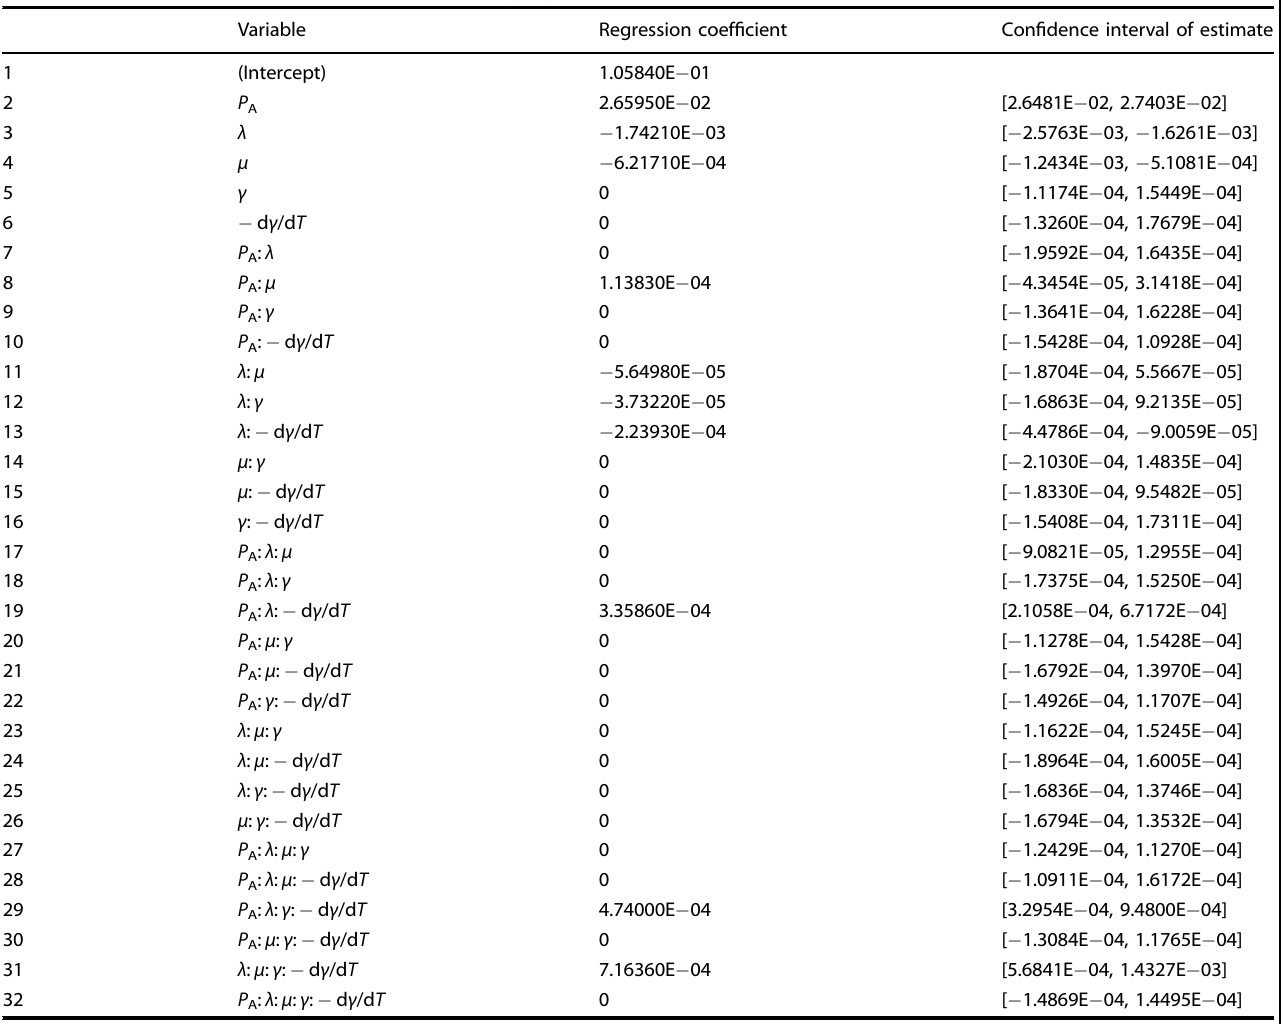
Table 5. LASSO method applied to the full model, Y X